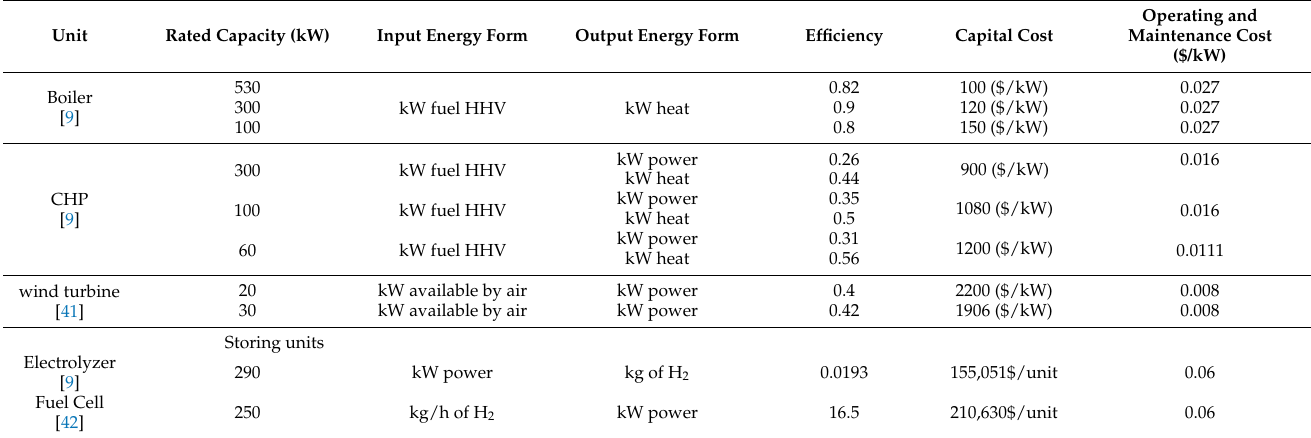
Table 3. Technical and economic information about the energy conversion and storing